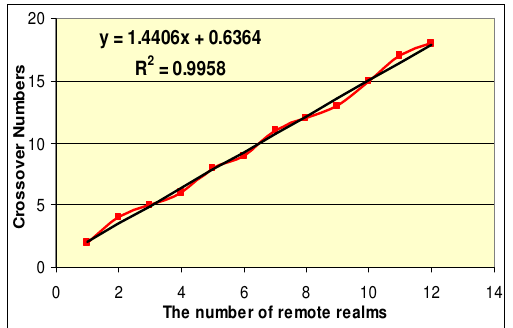
Figure 12. Response Times vs. Authentication Request Rates when m = 2